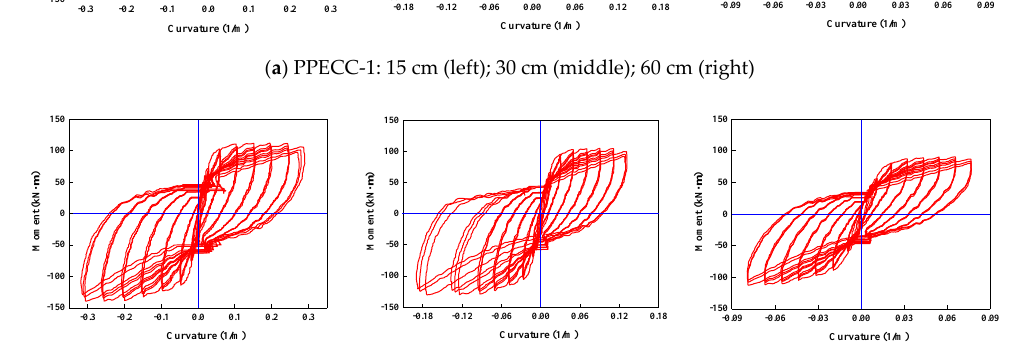
( b ) PPECC-2: 15 cm (left); 30 cm (middle); 60 cm (right)